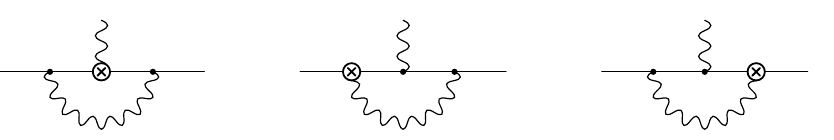
Figure 2 . One-loop correction to the matrix element of L eγ . There is also a wave-function correction, which is not